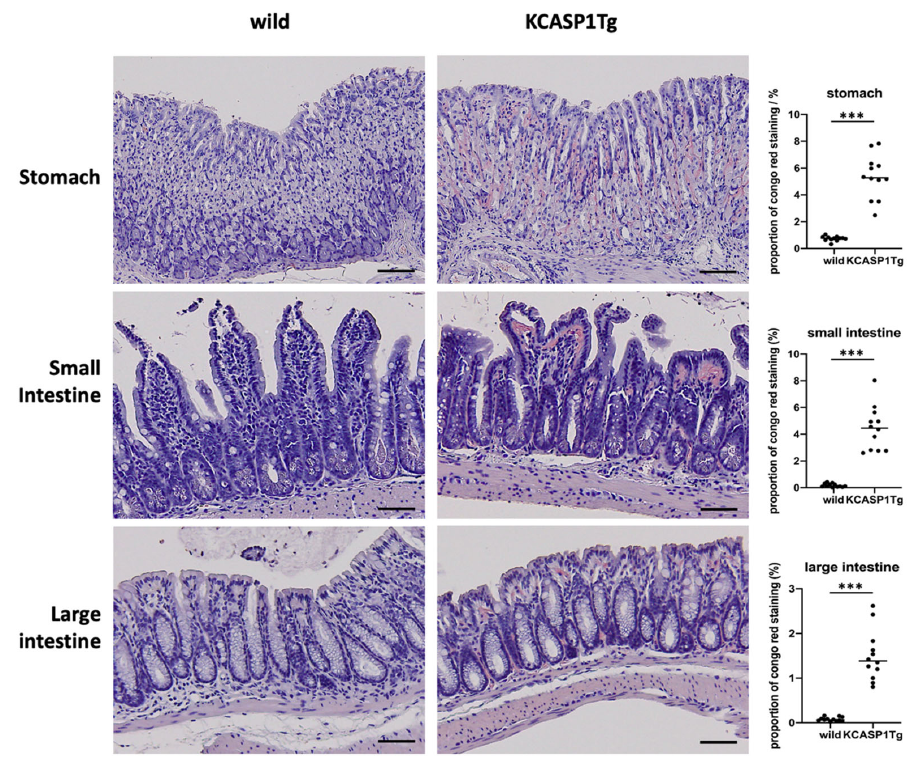
Figure 2. Histological analysis showed the amyloid deposition in KCASP1Tg mice. At 16 weeks of age, the stomach, small intestine, and large intestine were collected from the WT and KCASP1Tg mice and stained with Congo red. Compared with the WT mice, the KCASP1Tg mice had more severe amyloid deposition in the gastric mucosa and intestinal epithelial cells. Scale bar = 50 μ m. There was a significant increase in the Congo red stain ‐ positive area in the KCASP1Tg mice. All data were expressed as means ± SDs. *** p < 0.001 between KCASP1Tg and wild ‐ type mice by Mann–